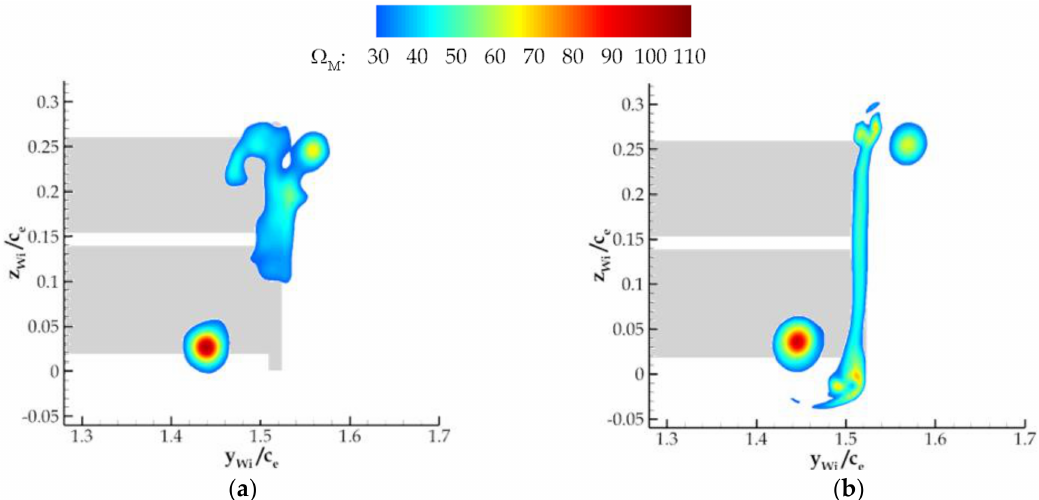
Figure 14. Contours showing a comparison of the mean vorticity magnitude of the inboard flap tip vortex at x Wi /c e = 1.019. ( a ) Experiment; ( b ) Numerical